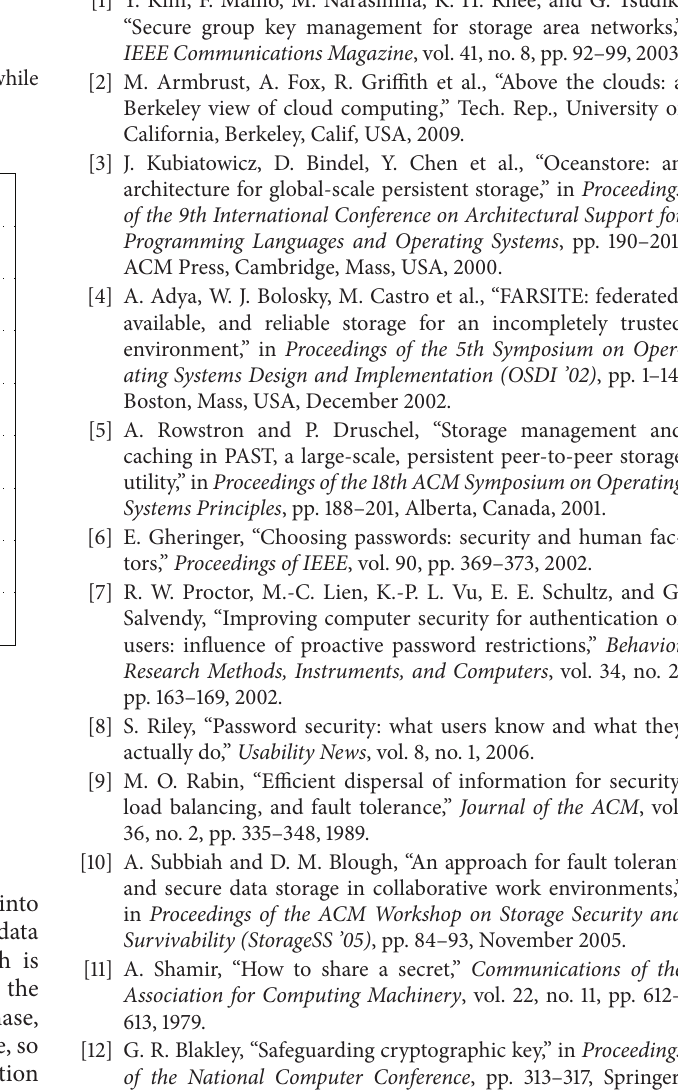
algorithm to encrypt and partition original data object into fragments. EPPA strengthens the confidentiality of